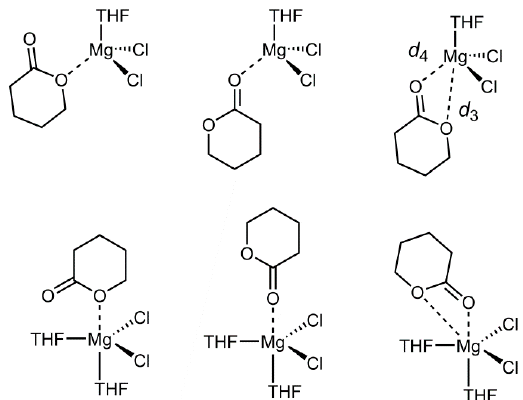
Figure 2. Investigated types of lactone-ligated magnesium complexes. Top: Tetrahedral geometry; Bottom: Trigonal-bipyramidal coordination. From left to right: endocyclic activation, carbonyl activation and chelating activation.